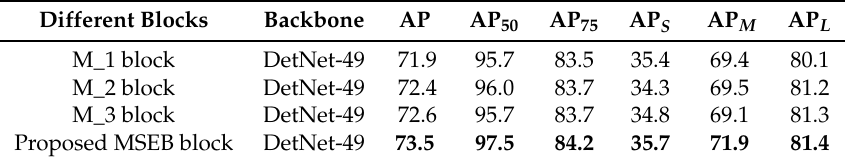
Table 3. Performance comparisons between the Proposed MSEB block and other blocks in terms of MS COCO metric. The bold numbers represent the best